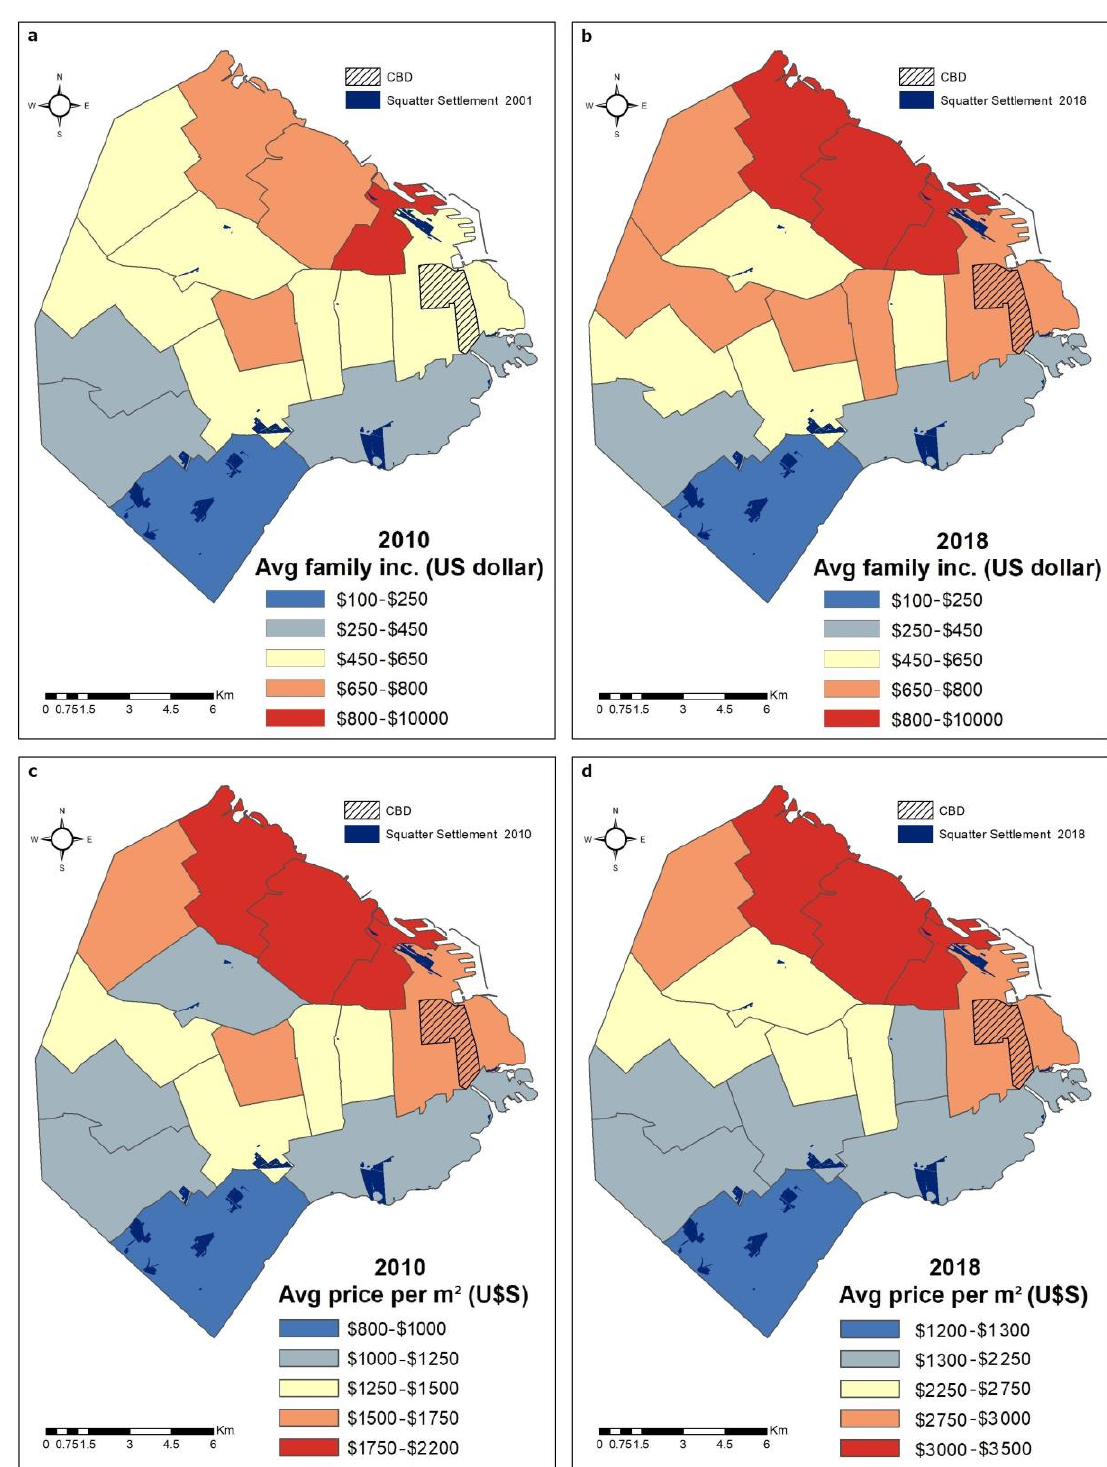
Figure 2. Average family income in ( a ) 2010, and ( b ) an average price of a 3-room apartments per m 2 in ( c ) 2010, and ( d ) 2018 in CBA. Data from DGEyC [46].